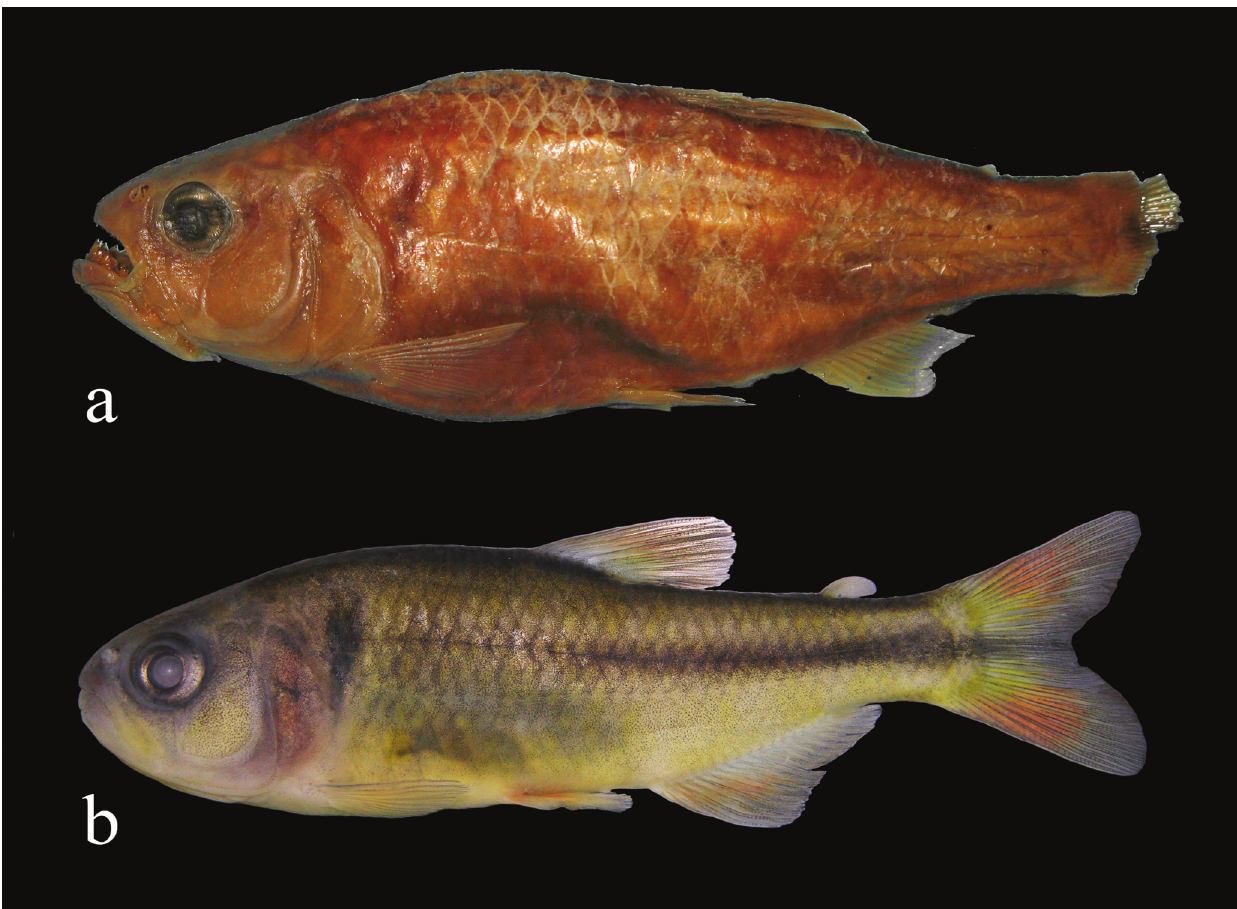
Fig. 1. Astyanax goyanensis . ( a ) MNRJ 4129, holotype, female, 89.2 mm SL; rio dos Couros, Chapada dos Veadeiros, Goiás State, Brazil (anal-fin incomplete); ( b ) UFRGS 11291, topotype, male, 56.7 mm SL; small stream tributary of rio dos Couros